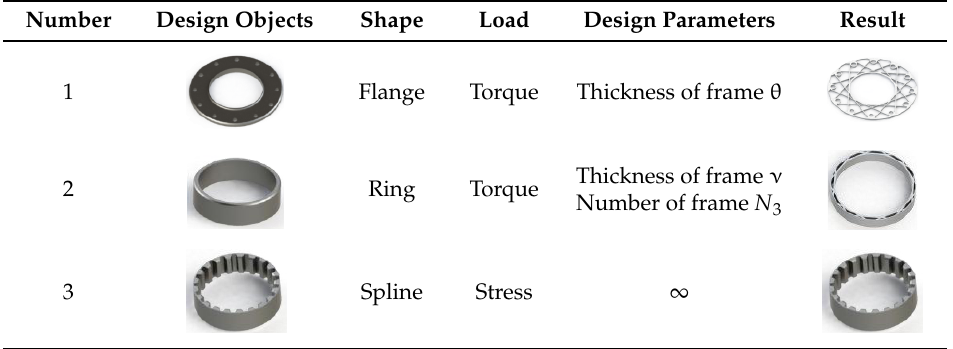
Table 3. Disassembly of connecting plate.